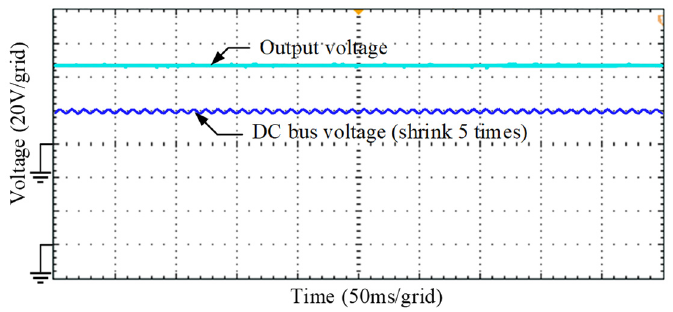
Figure 30. Input current and voltage waveforms.